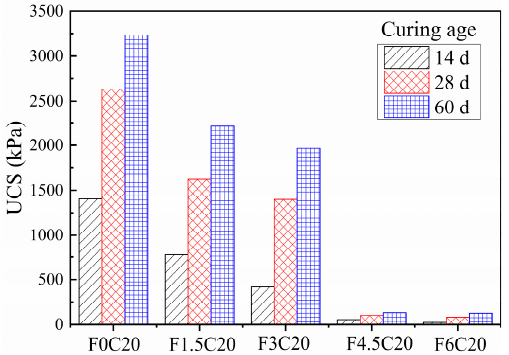
Figure 4. Unconfined compressive strength of CDS with 20% cement content.